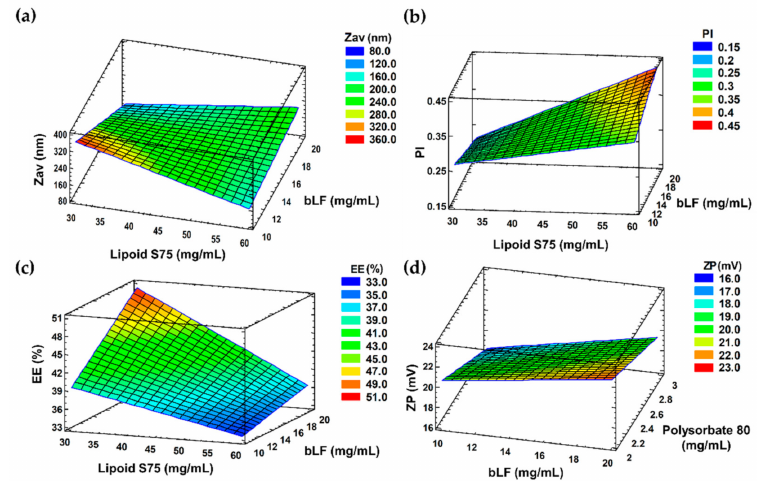
Figure 1. ( a ) Z av , ( b ) PI, and ( c ) EE (%) surface response at a fixed P80 concentration (3 mg · mL − 1 ). ( d ) ZP surface response at a lipid concentration (30 mg · mL − 1